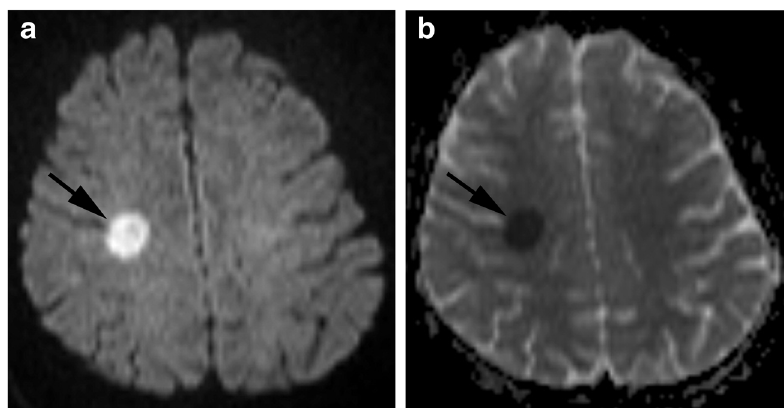
Fig. 7 Methotrexate